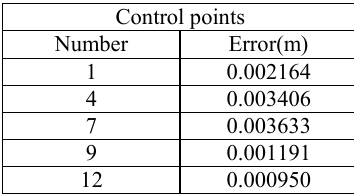
Table 4. The errors of the control points